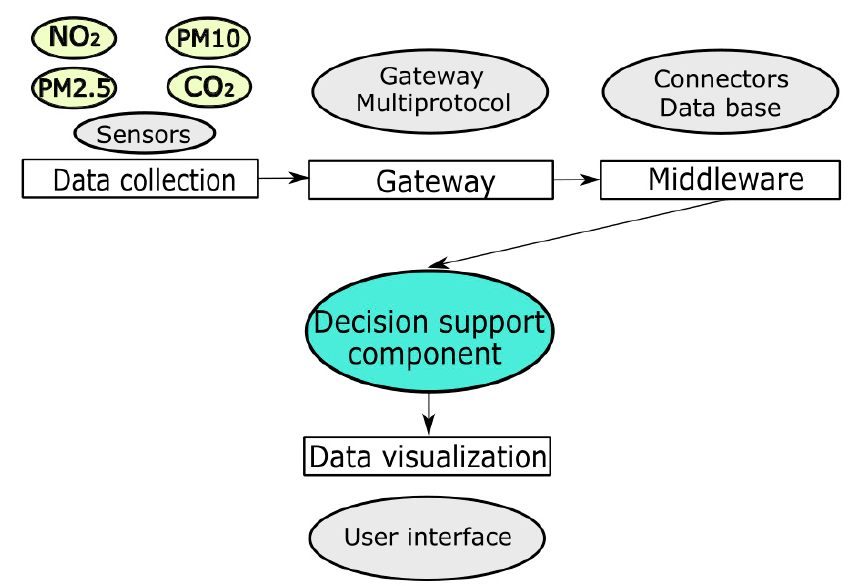
Figure 1. The architecture of the ESTABLISH (Environmental Sensing To Act for a Better Quality of Life: Smart Health) solution .